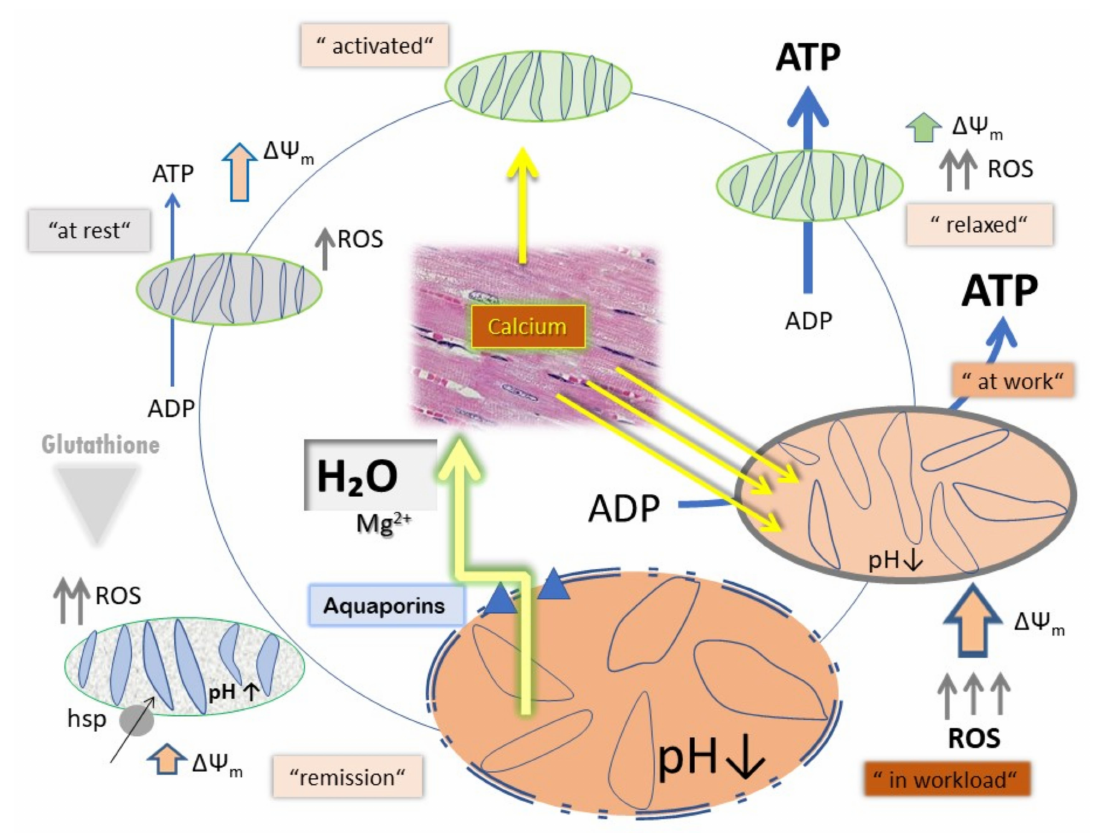
Figure 5. Schematic representation of variations in mitochondrial functional components under different physiological states, e.g., relaxed, activated and activated under work